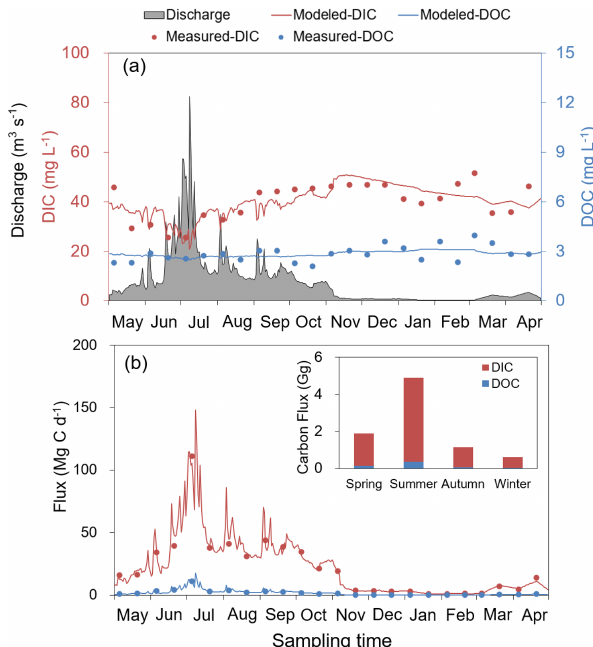
Figure 2. Discharge, dissolved inorganic carbon (DIC), and dis- solved organic carbon (DOC) concentrations (a) and fluxes (b) ex- ported from Shaliu River at SLH-4 station from May 2015 to April 2016. The modeled concentrations in (a) and modeled fluxes in (b) are derived from load estimator (LOADEST). The inserted columns in panel (b) show the seasonal variations in carbon fluxes classi- fied as follows: spring (May to June), summer (July to September), autumn (October to November) and winter (December to the next